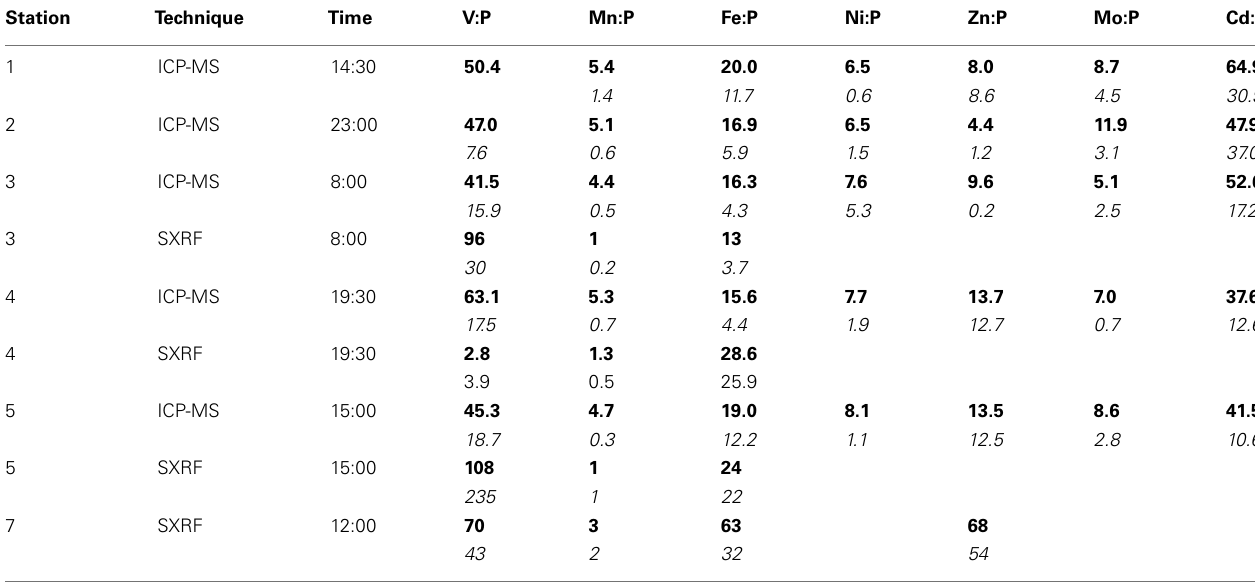
Table 3 | P-normalized mean metal stoichiometries of Trichodesmium measured by ICP-MS or SXRF.